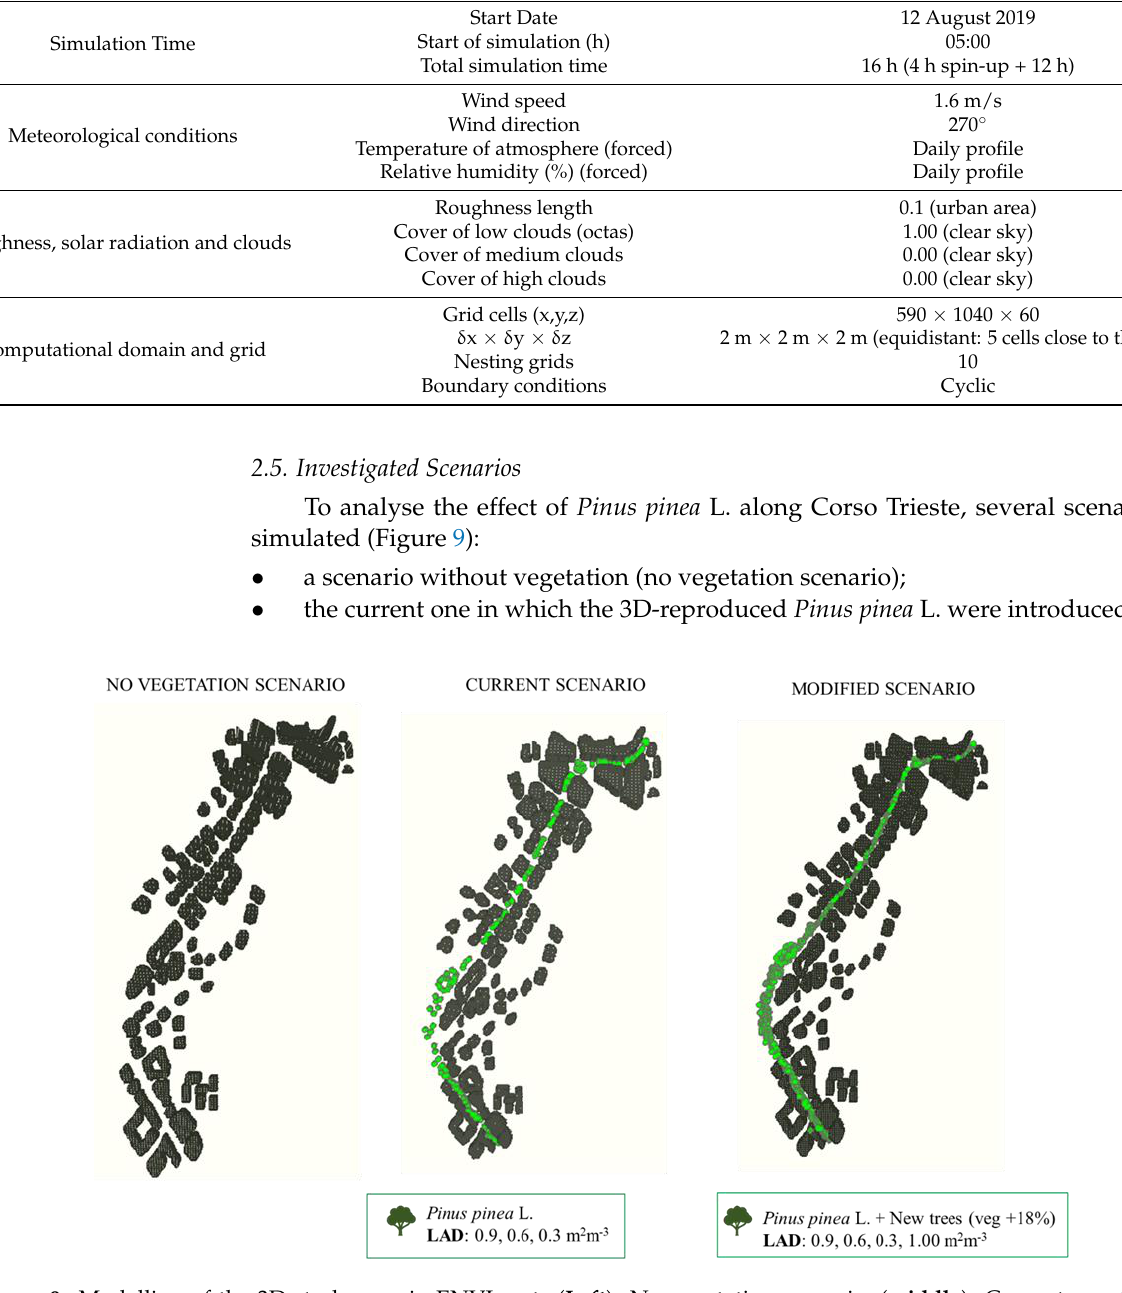
Figure 9. Modelling of the 3D study area in ENVI-met. ( Left ): No vegetation scenario; ( middle ): Current vegetation scenario; ( right ): Modified scenario.